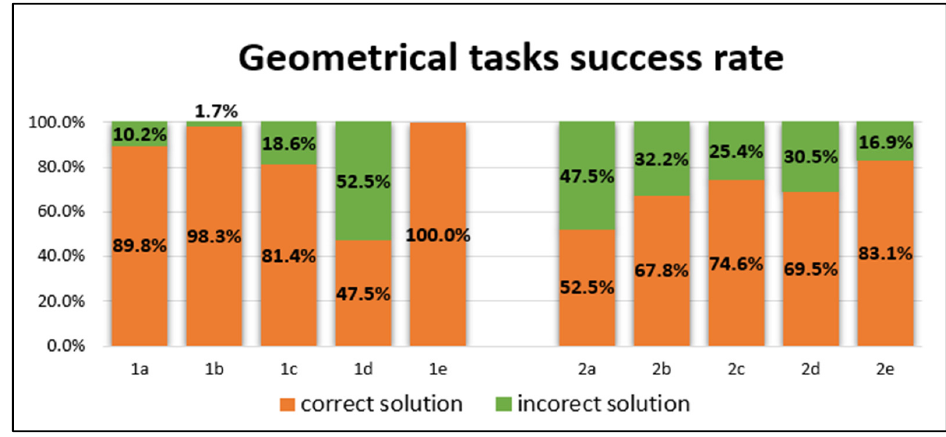
Figure 4. Geometrical tasks success rate.